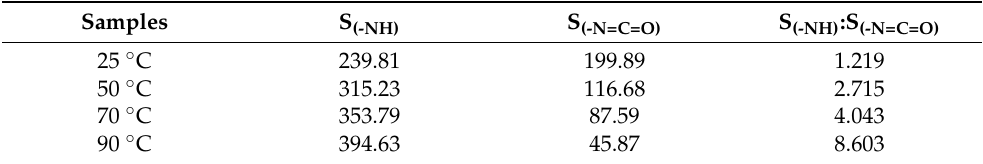
Table 2. Integral area of carbamate groups (-NH) and isocyanate groups (-N=C=O) of emulsions suffering from 10min heat via different temperature in FT-IR spectra.